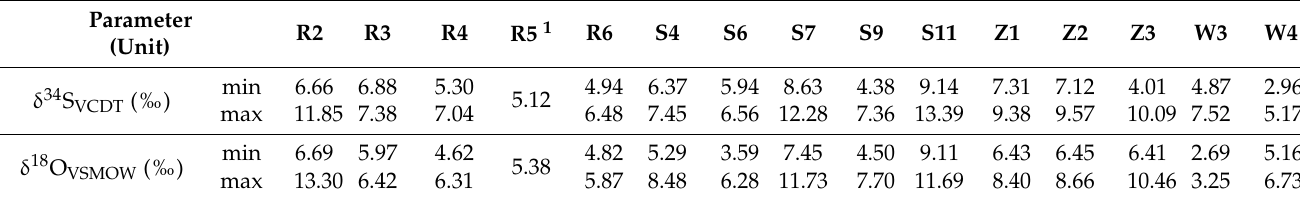
Table 2. Results of measured δ 34 S and δ 18 O in sampled water (maximum and minimum values).